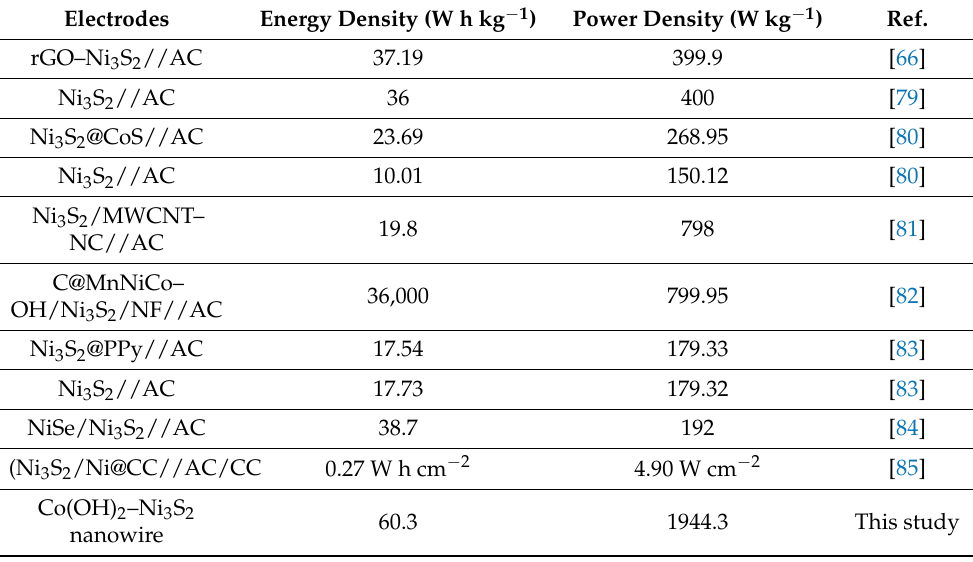
Figure 8. Cyclic voltammograms of the Co 0.5 –Ni 3 S 2 //AC device ( a ) in different voltage windows and ( b ) at different scan rates. ( c ) Galvanostatic charge–discharge curves of the Co 0.5 –Ni 3 S 2 //AC device at 8–50 mA cm −2 and (inset) cycle retention at 20 mA cm −2 , and ( d ) EIS and fitting results of the Co 0.5 –Ni 3 S 2 //AC device after 1 and 1000 cycles. Table 2. Comparison of the electrochemical energy storage performance observed in this study with those of previously reported asymmetric devices based on Ni 3 S 2 and AC electrodes